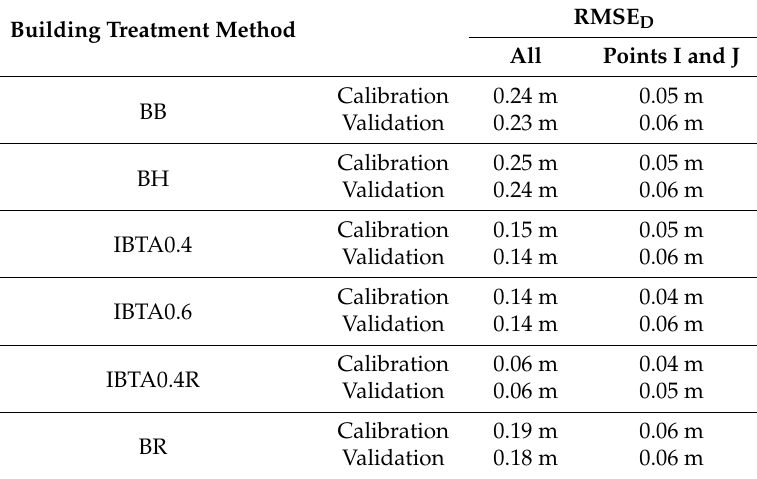
Table 3. Calibration and validation results of each building treatment